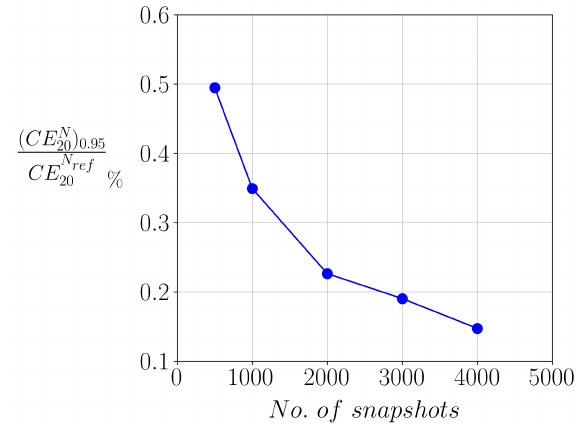
Figure 7. Variation of the 95% confidence interval of the cumulative energy of the first 20 POD Modes ( CE N ) 0.95 with the examined sub-sample dataset sizes, expressed as the percentage of the cumulative 20 energy of the first 20 POD Modes of the reference dataset CE N ref